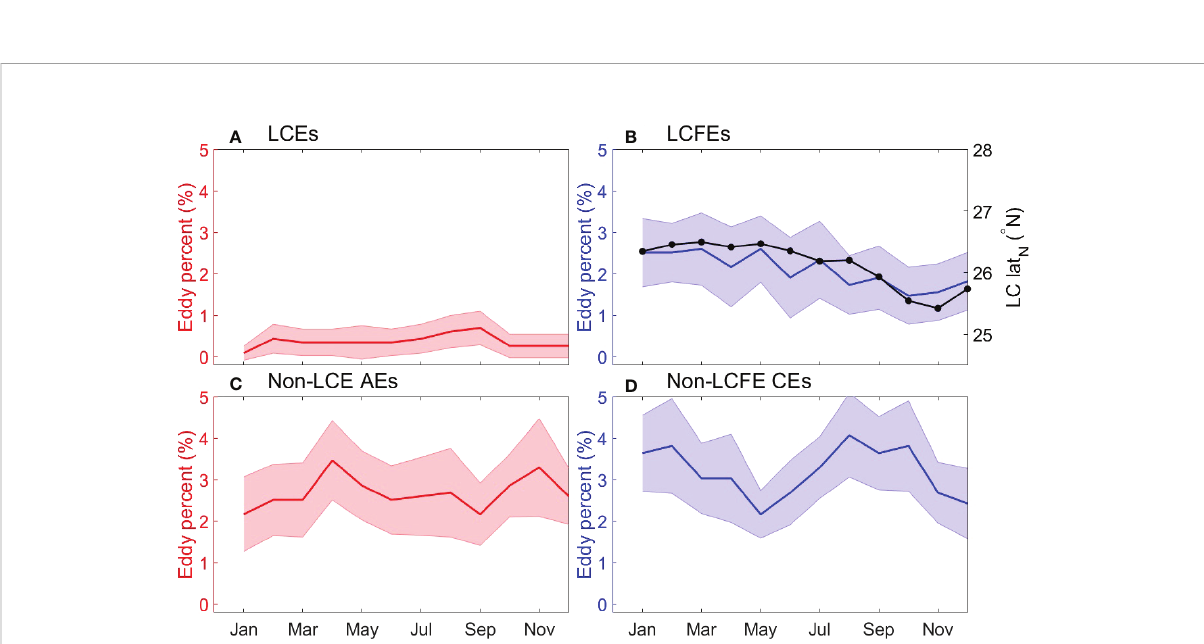
FIGURE 8 (A) The percentage of birth number of LCEs relative to the total eddy birth number. (B) The percentage of birth number of LCFEs relative to the total birth number. The black line in (B) represents the monthly climatology of the LC position. (C) The percentage of birth number of non-LCE AEs relative to the total birth number. (D) The percentage of birth number of non-LCFE CEs relative to the total birth number. The shading denotes the 95% con fi dence level represented by two times standard deviation of eddy percentage in each month.